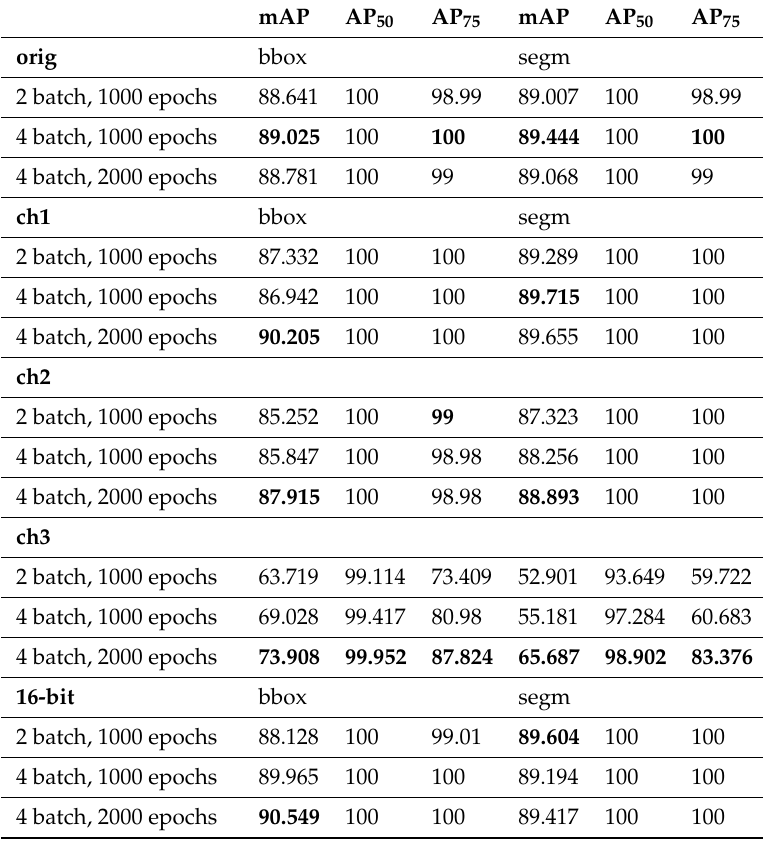
Table 2. Testing results for Mask R-CNN pre-trained learning and 200 images.